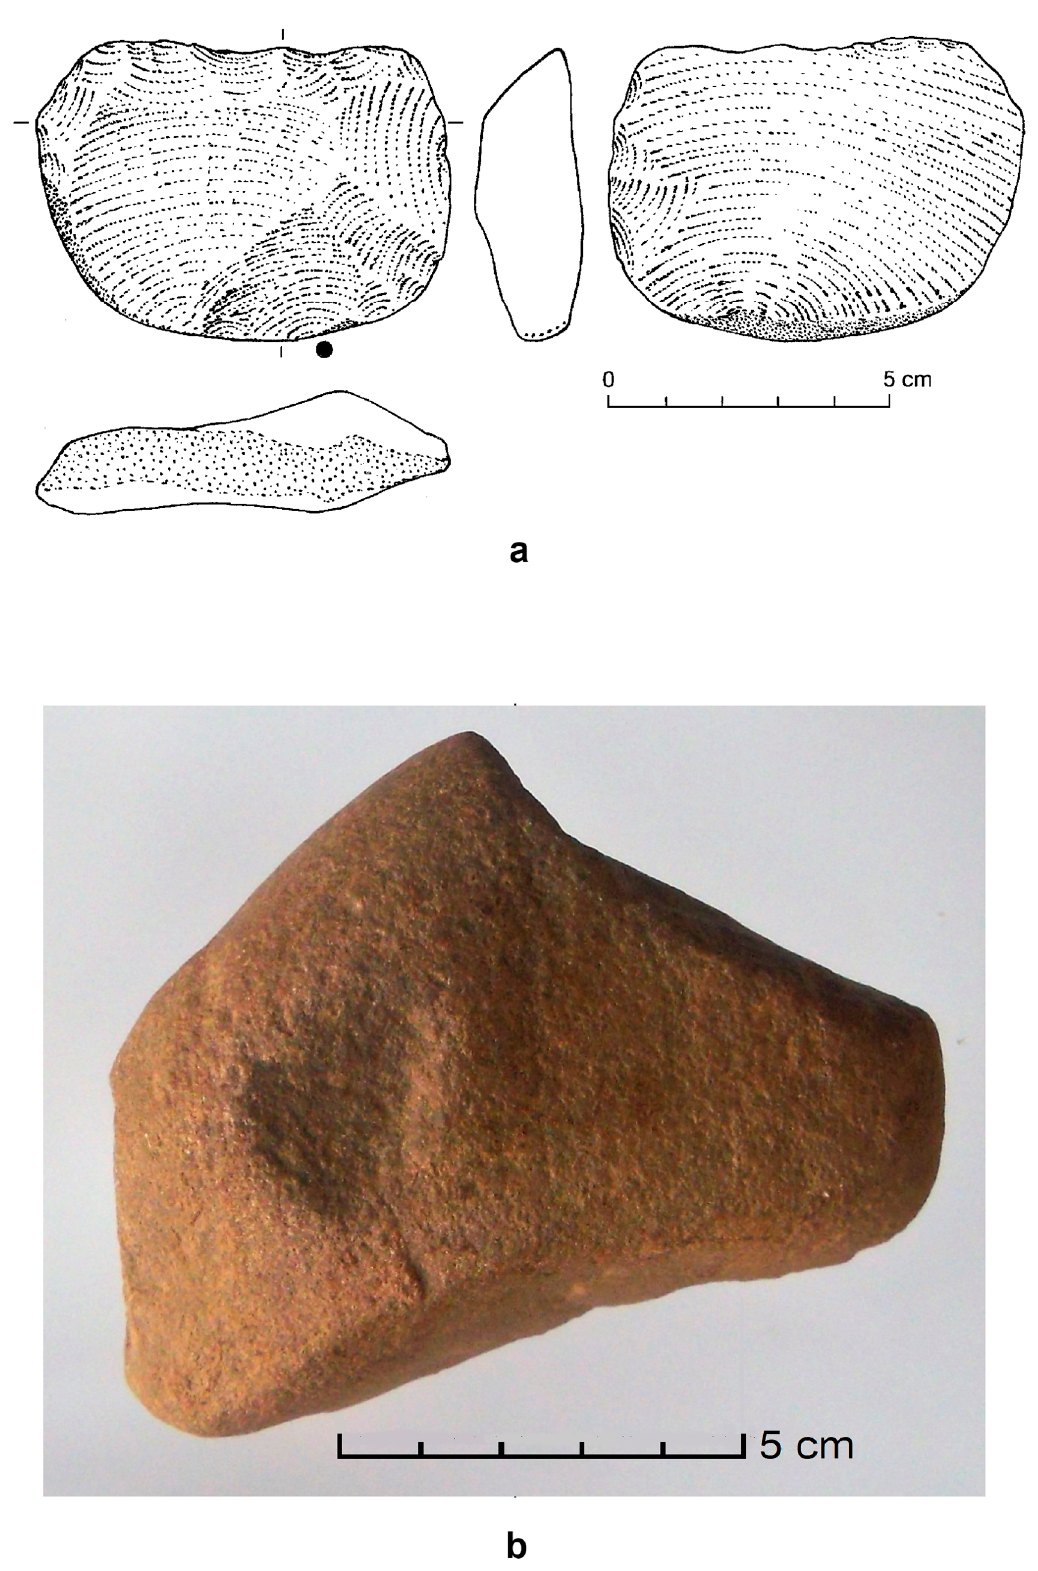
Figure 11. Münster-Sarmsheim. ( a ) End struck quartzite flake (sraper); ( b ) silified sandstone with a typical cupule and use wear impacts. (Photo: C. Humburg, drawing: L. Fiedler.).